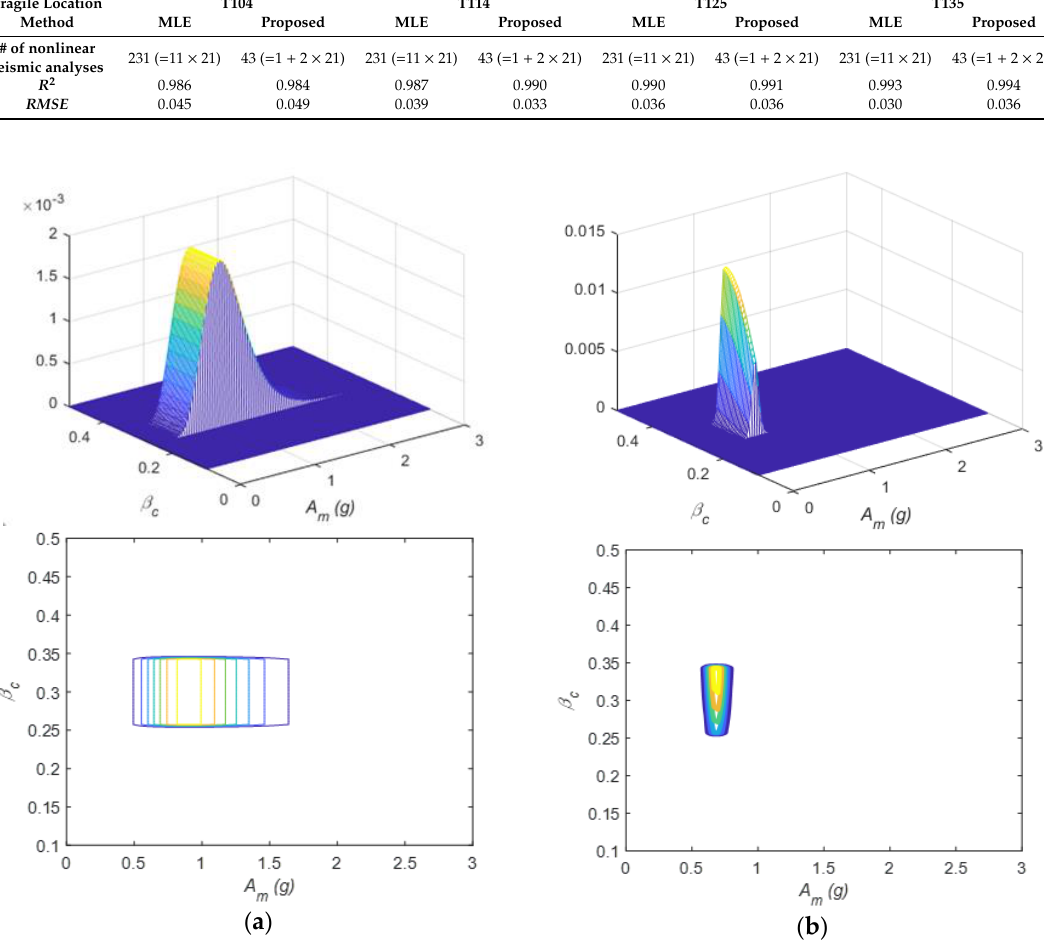
Figure 8. Distribution of main parameters for piping seismic fragility curve (regarding the limit state of T104): ( a ) a prior probability distribution and ( b ) a posterior probability distribution.